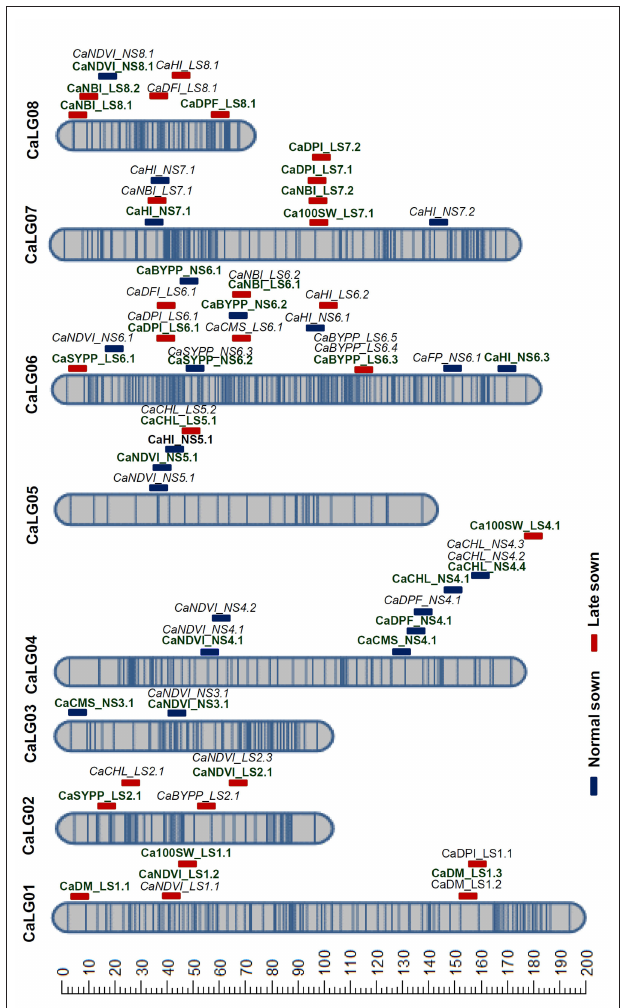
FIGURE 2 | Genetic map and QTLs for heat tolerance-related traits. A genetic map comprising 788 SNPs distributed in eight linkage groups (CaLG01–CaLG08) spanning 1,125cM was constructed using RIL population derived from DCP 92-3 × ICCV 92944. The blue and red-colored bars indicate the QTLs identified under normal and late sown conditions, respectively. The major QTLs are indicated in bold font and the minor QTLs in